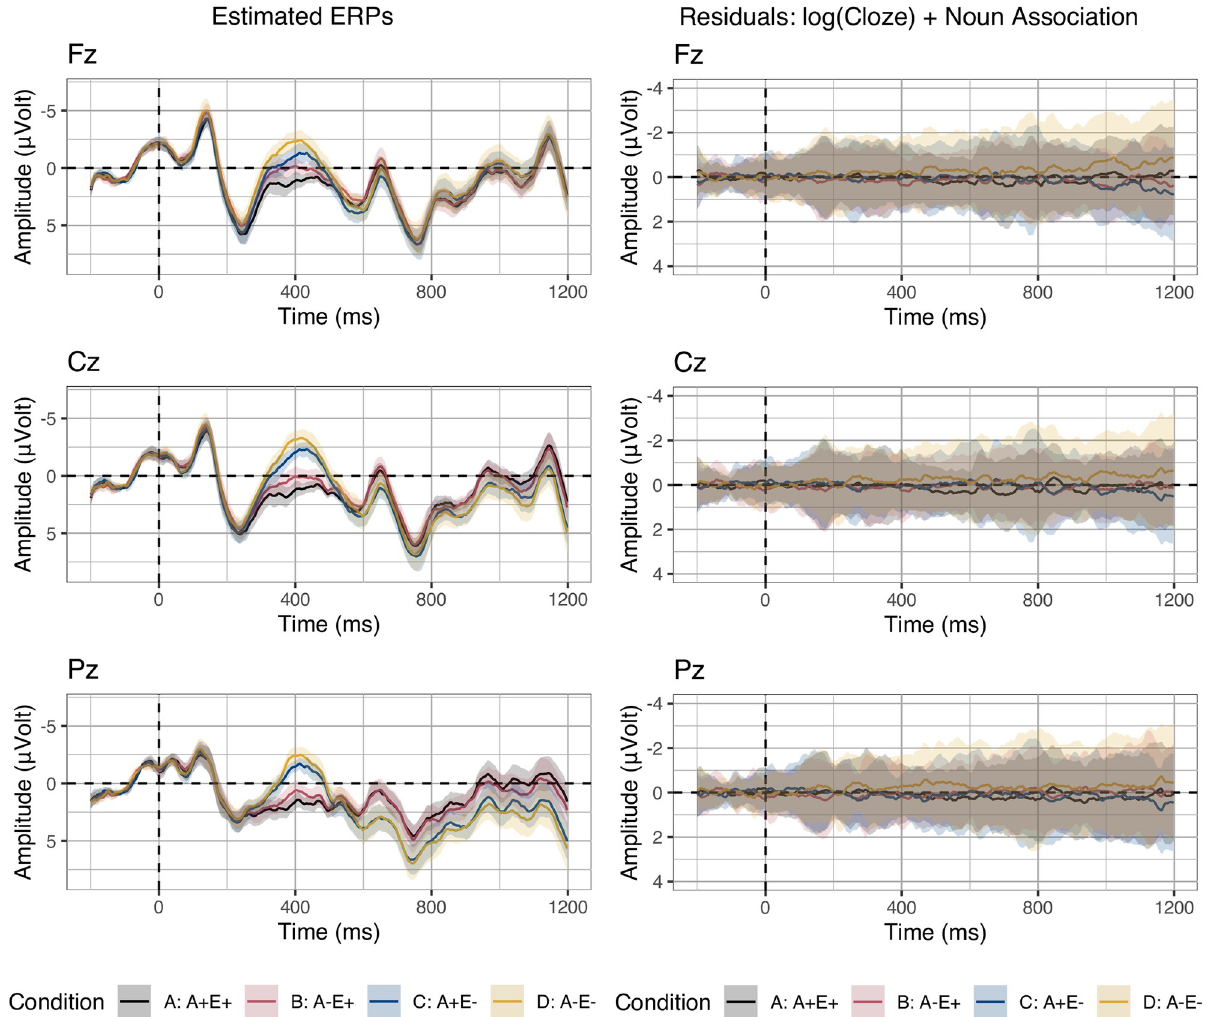
Fig 5. Estimated ERPs and residual error. Estimated ERP waveforms (left) and residual error (right) computed from lmerERP models with log(Cloze) and noun-target association as predictor. Ribbons indicate standard error computed from the per-subject per-condition averages.